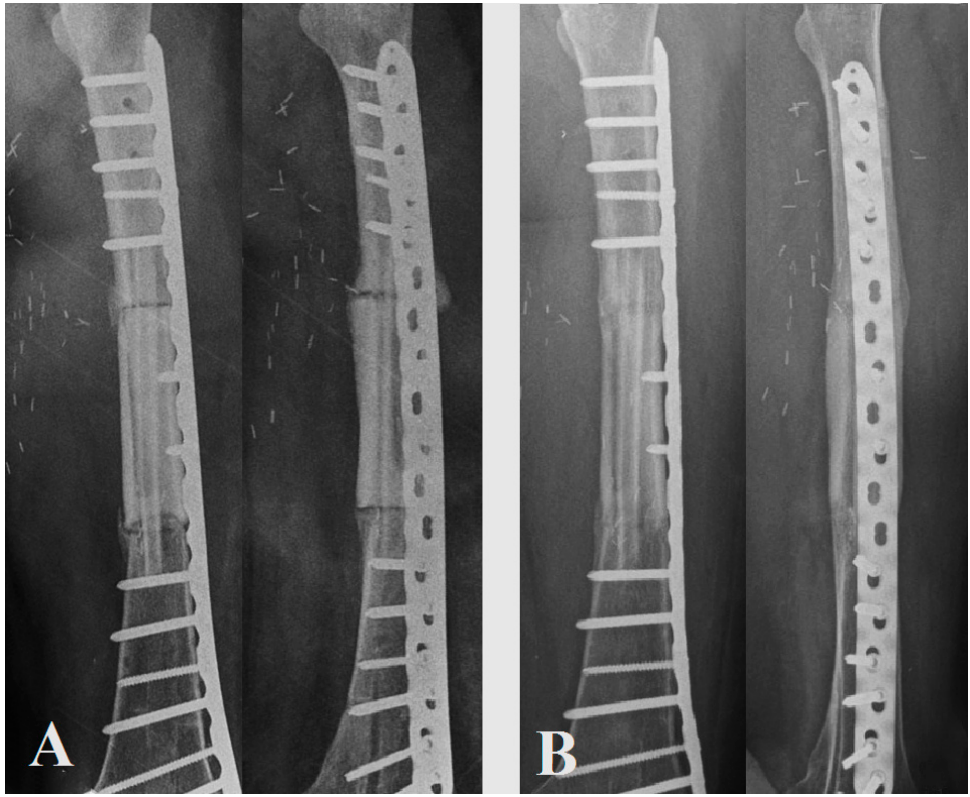
Figure 4. ( A ) Control X-rays for patient No. 1 at 3 months postoperatively; ( B ) control X-rays for patient No. 1 at 10 months postoperatively.